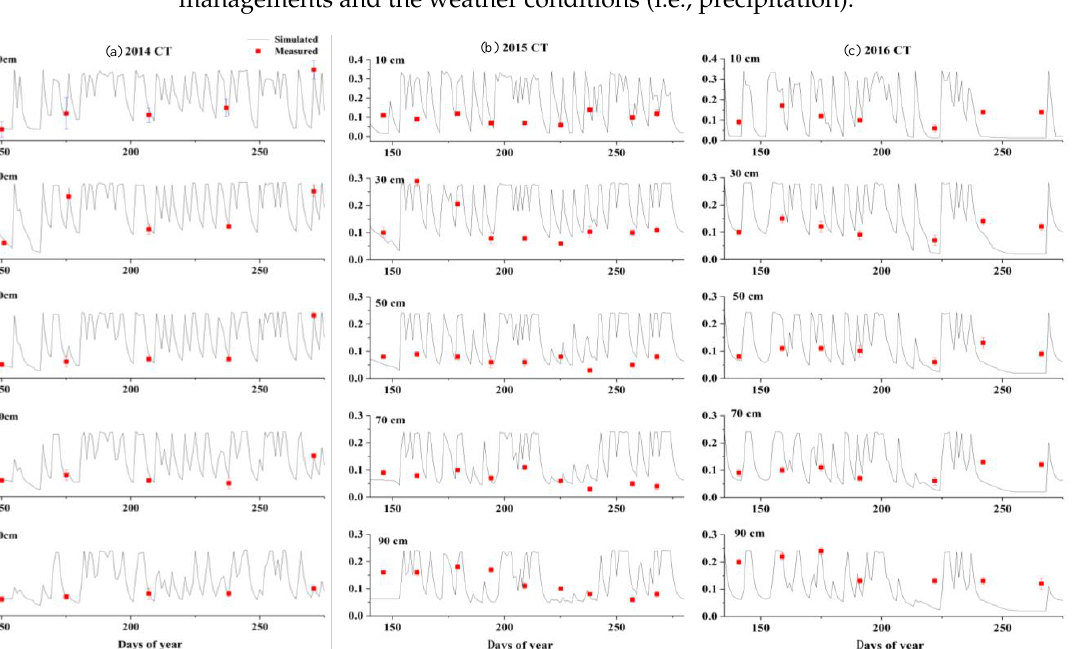
Figure 6. Measured and simulated soil water contents for NT at different soil depths during 2014‒ 2016.